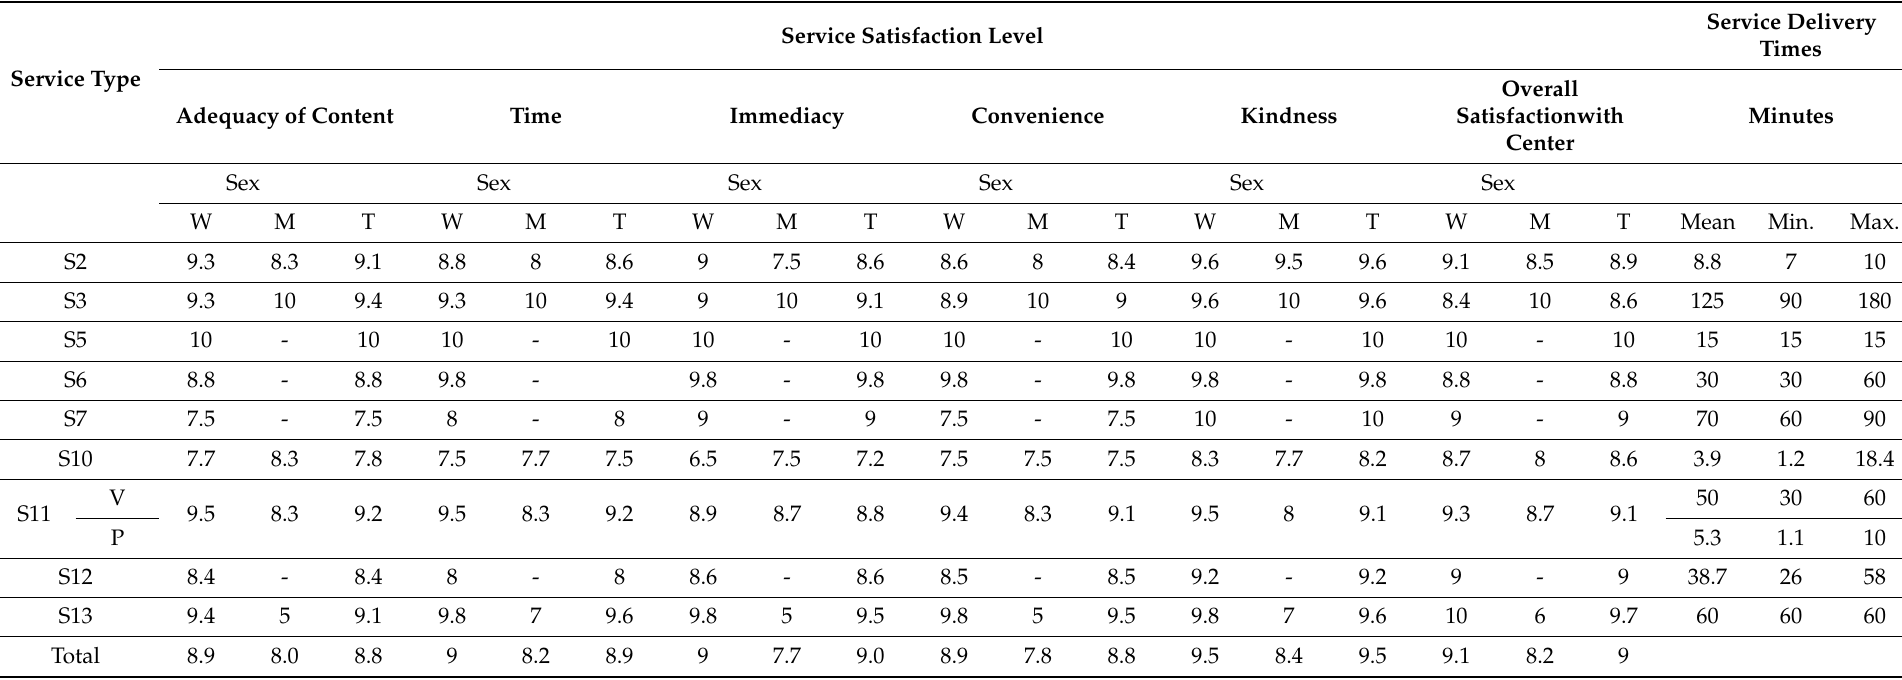
Table 2. Service satisfaction level and service delivery